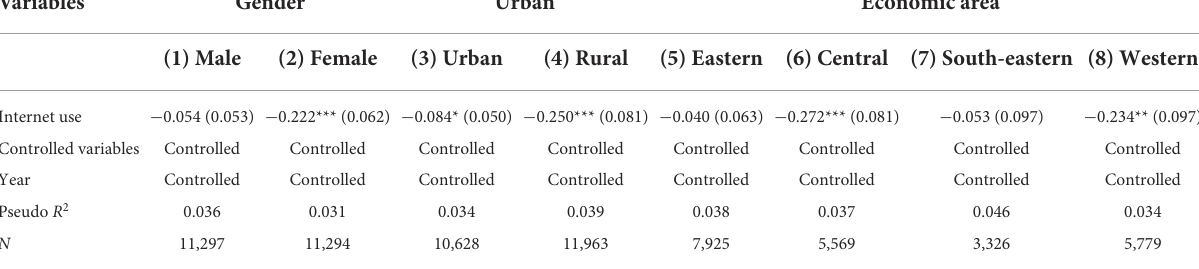
TABLE 5 Heterogeneity test results.